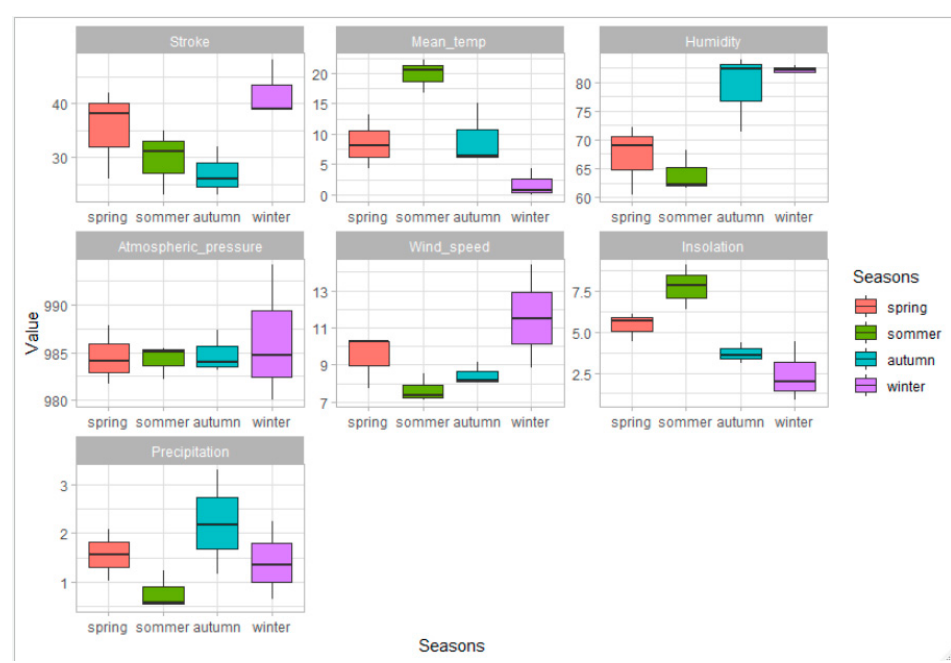
Figure 3. Box plot graph presenting the distribution of all the meteorological parameters for individual seasons. Temp- temperature.